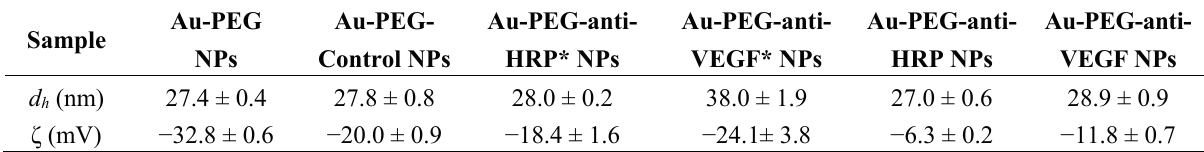
Table 2. Summary of mean hydrodynamic diameters and zeta-potentials determined in